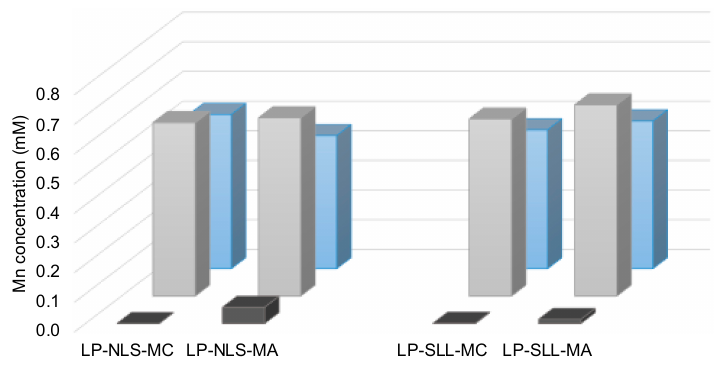
Figure 7. MC and MA concentration in the aqueous phase (dark grey), in the lipid phase (light grey)